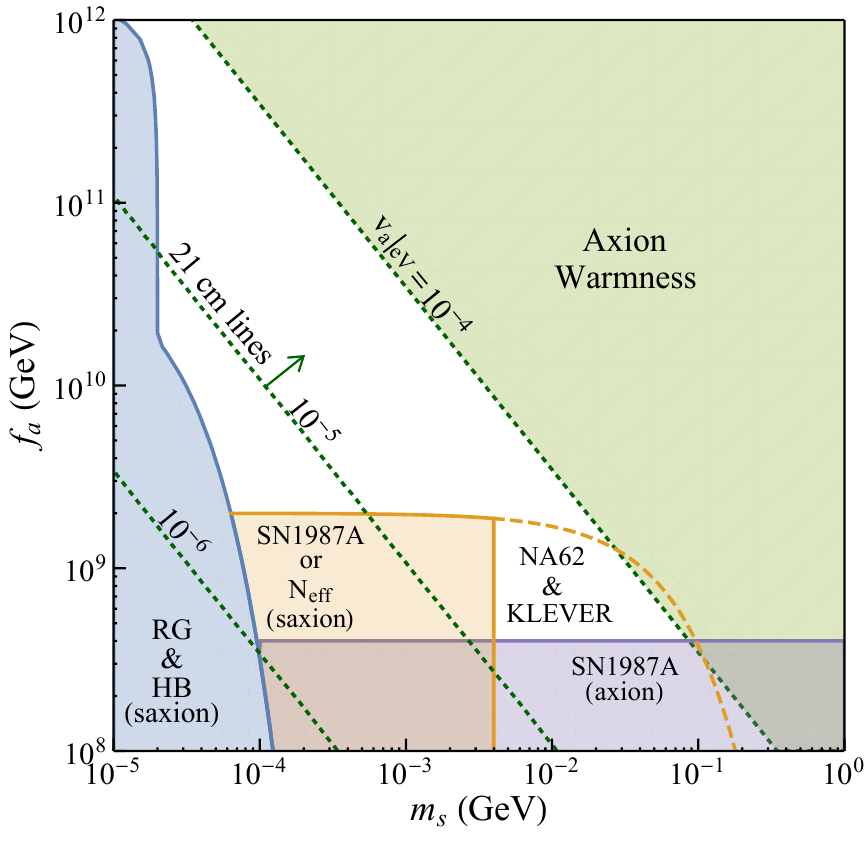
Figure 2 . Constraints on the saxion mass m s and the axion decay constant f a